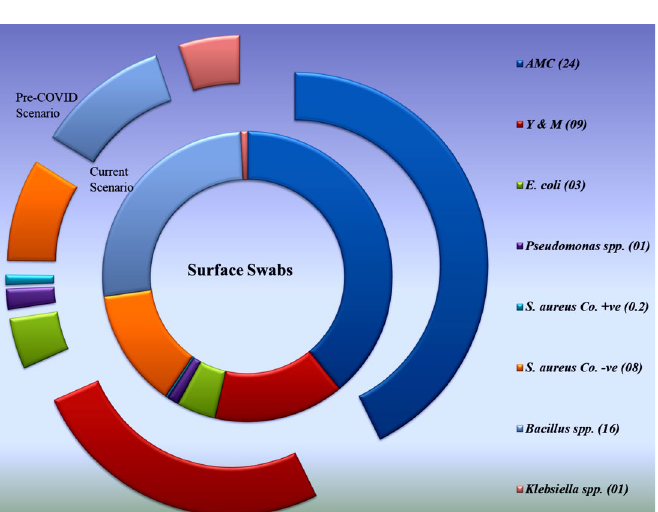
Fig. 2. Pictorial representation of data for the swab samples collected between the period and its isolation